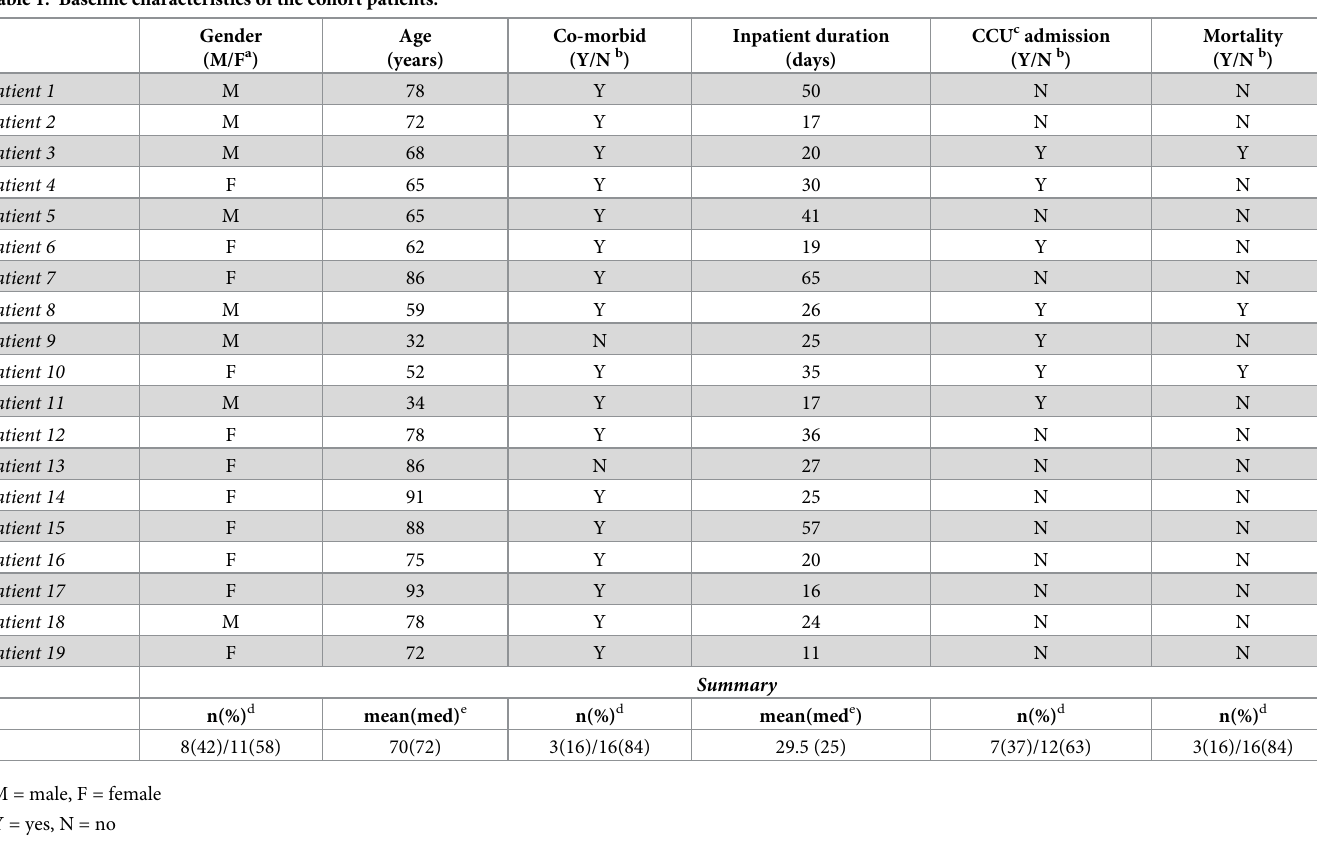
Table 1. Baseline characteristics of the cohort